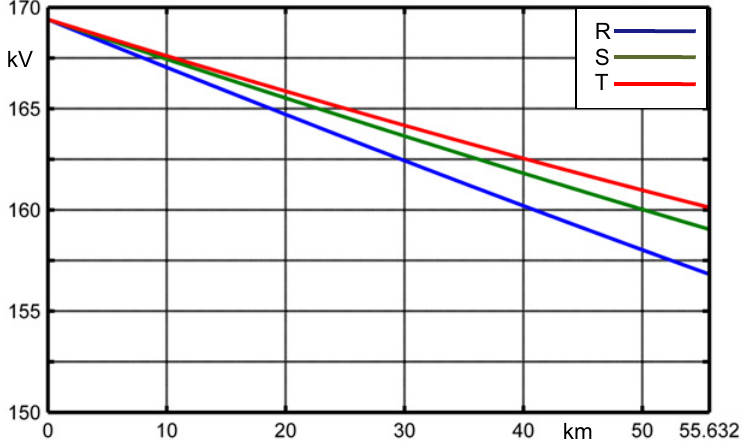
Figure 6. Line-to-earth voltage magnitudes along the